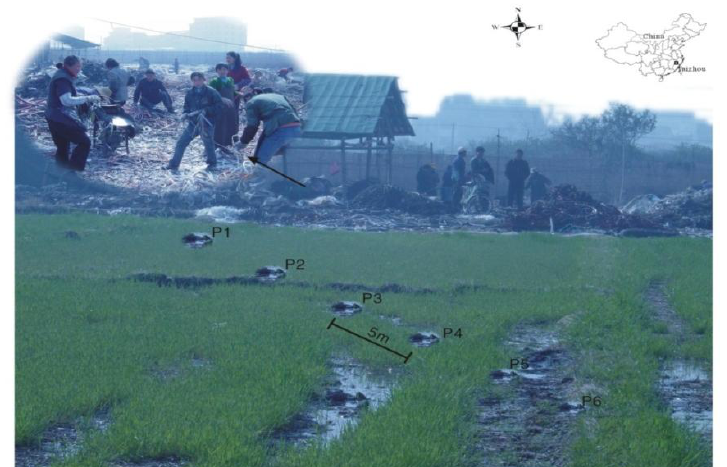
Figure 1. Map of study area and the six sampling points